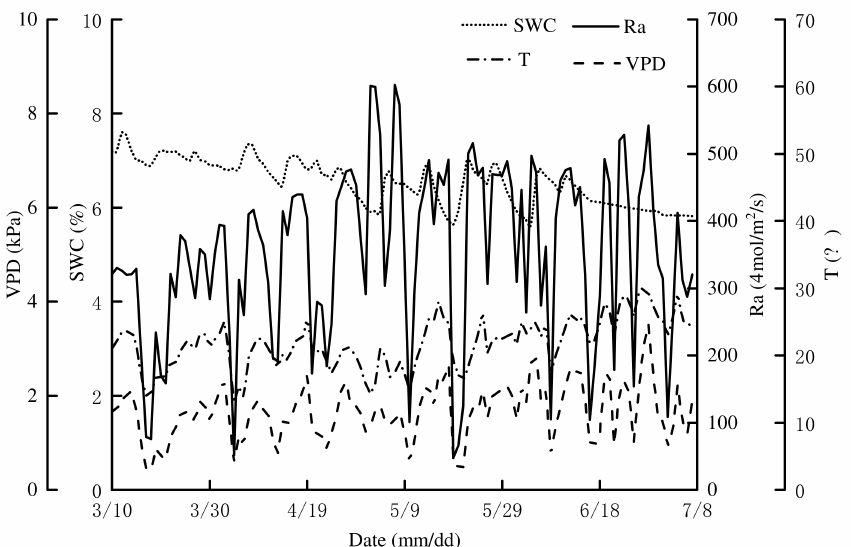
Figure 1. Daily mean values of meteorological data (Ra, T and VPD represent solar radiation, air temperature and air vapor pressure deficit, respectively) and soil water content data (SWC represents soil water content measured by the ECH 2 O sensor in different treatments and different soil layers) during the growing